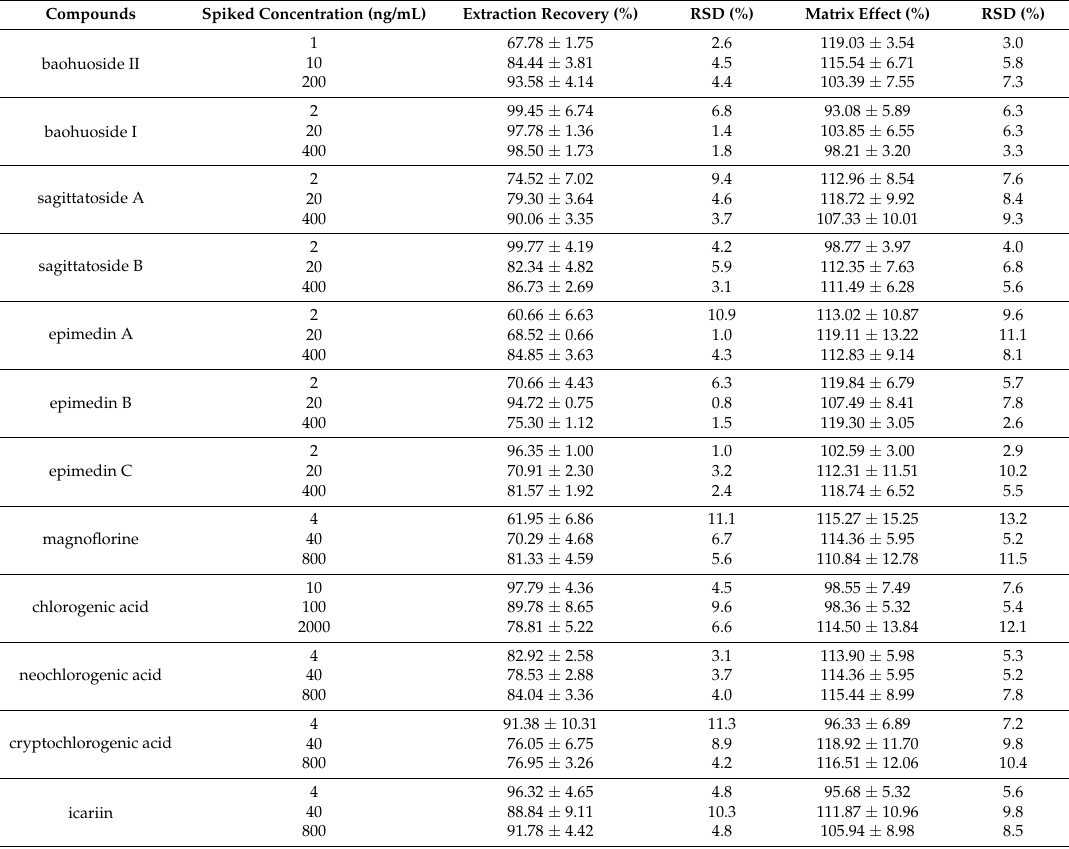
Table 3. Extraction recoveries and matrix effects of the analytes ( n =